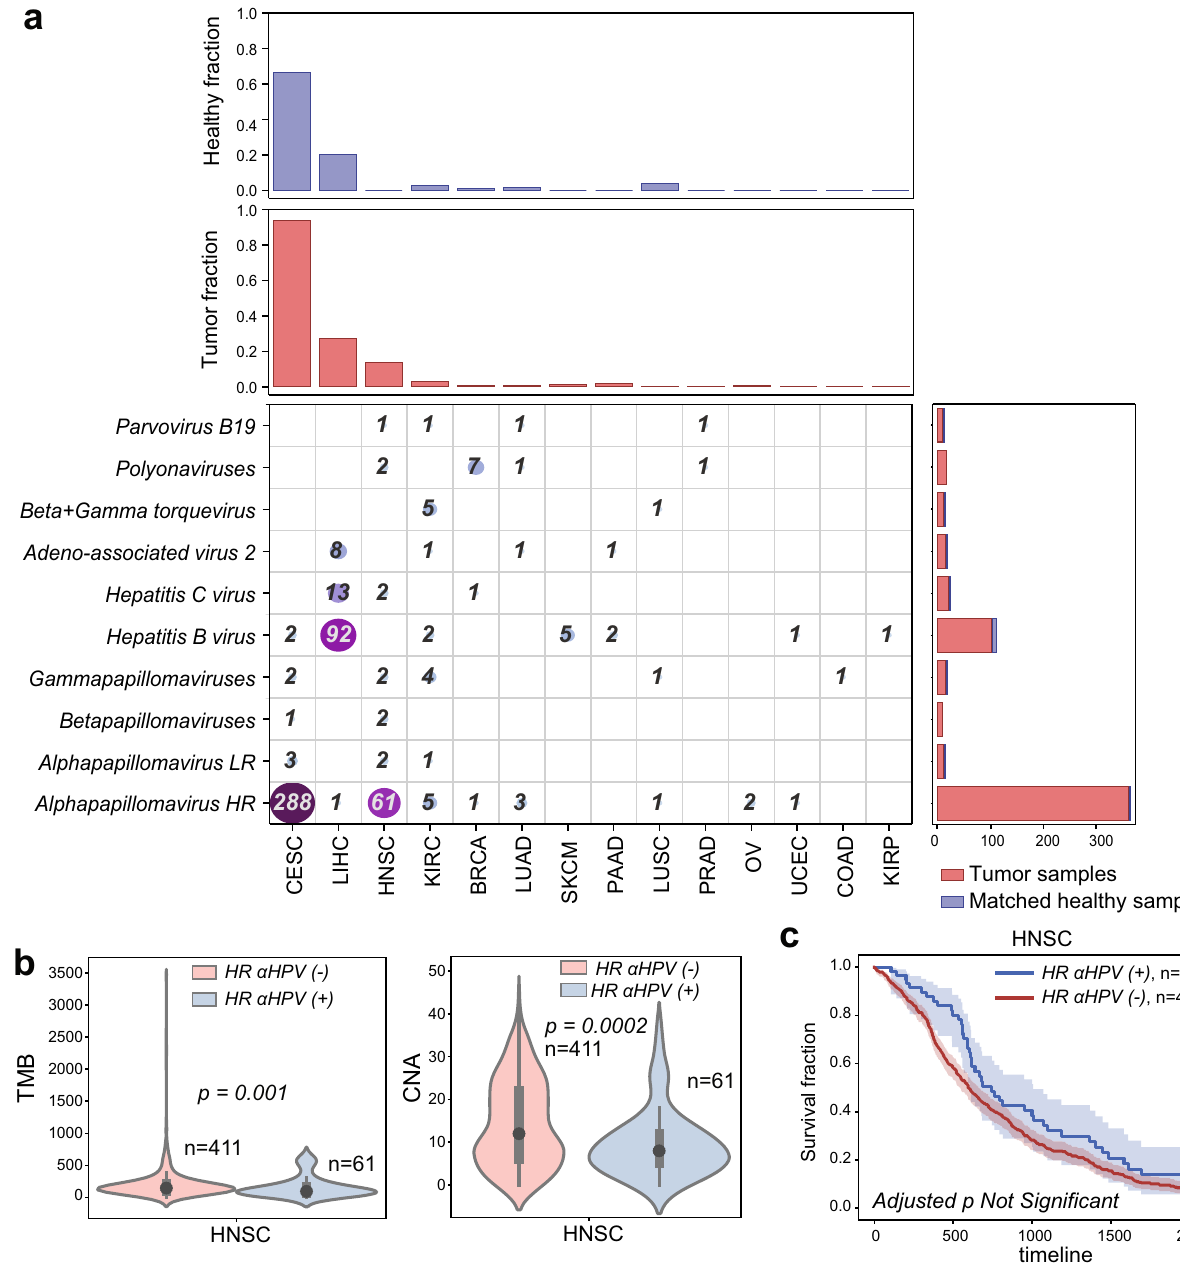
Fig.2|Referencehumanvirusesexpressedindifferenttumortypes.a Heatmap showing the total number of virus-positive samples identi fi ed from RNA sequen- cingindifferenttumortissues.Thetoppanelsshowthefractionoftumorandnon- cancersamplesinwhichviruseswereidenti fi ed.Therightpanelsshowthenumber of viruses found in tumor and non-cancer samples. b Violin plots comparing the tumormutationburden(TMB)andthenumberofchromosome-levelcopynumber alteration (CNA) between HNSC patients where expression of high-risk alpha papillomaviruses was detected vs those patients where expression of high-risk alpha papillomaviruses was not detected. Black dots represent the medians, and